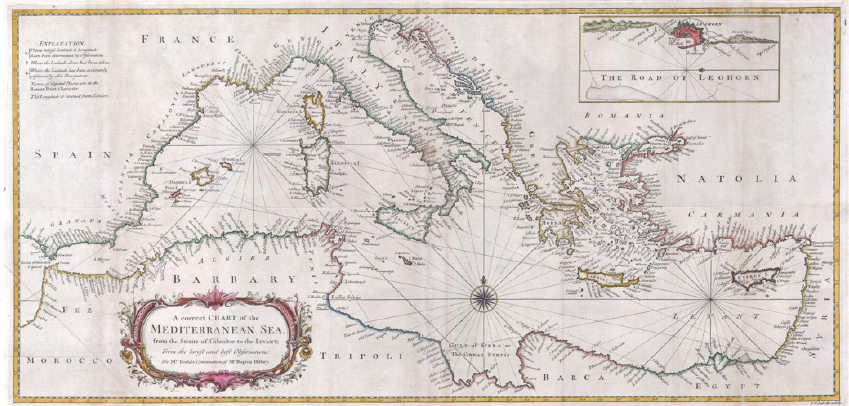
Figure 1. Richard William Seale, A correct Chart of the Mediterranean Sea, from the Straits of Gibraltar to the Levant: From the latest and best Observations: for Mr. Tindal’s Continuation of Mr. Rapin’s History, 1745, ink on paper, 35.56 × 72.39 cm.